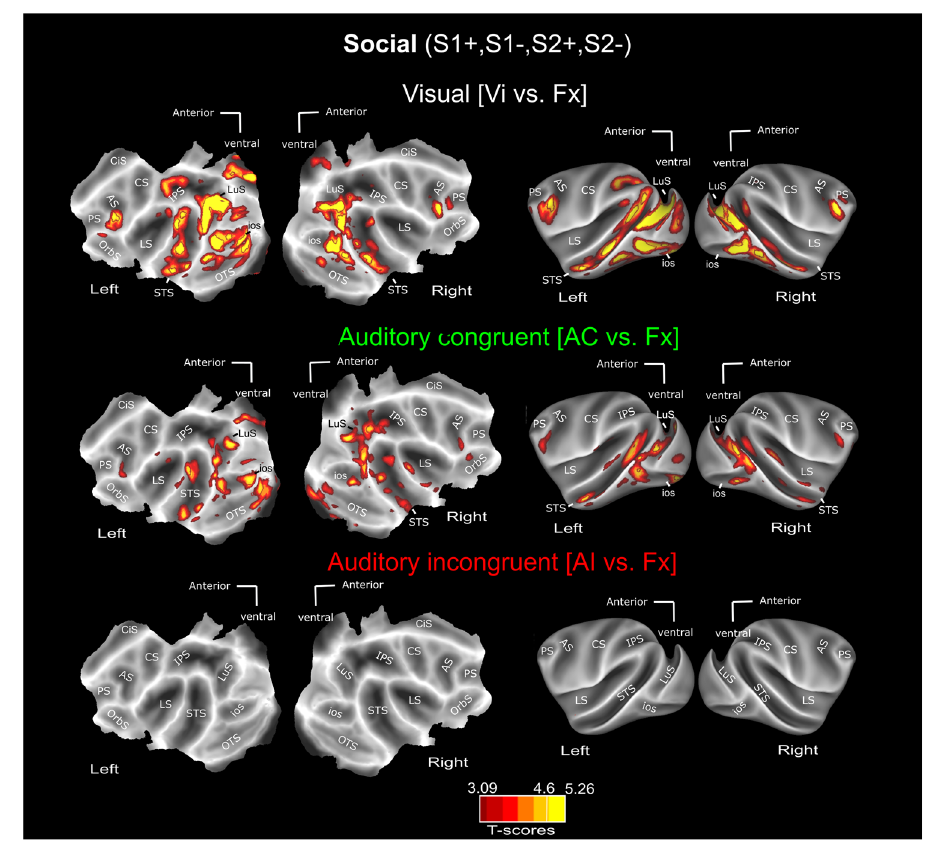
Fig. 4 | Whole-brain activation Social contexts (S1+, S1 − , S2+& S2 − ): main con- trasts. Whole-brain activation maps of the S1+, S2+ (social af fi liative 1 & 2), S1 − (socialaggressive)andS2 − (socialescape)runs,cumulatedoverbothmonkeys,for the visual (white, Vi vs. Fx), auditory congruent (green, AC vs. Fx) and auditory incongruent(red,AIvs.Fx).Note thattheACand AI conditions contain exactlythe same sound samples (coos, aggressive calls and screams). Darker shades of red